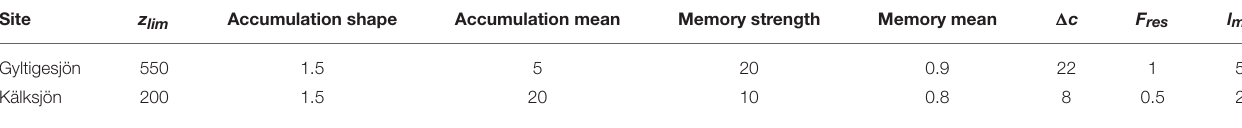
TABLE 1 | Age-depth model parameters.